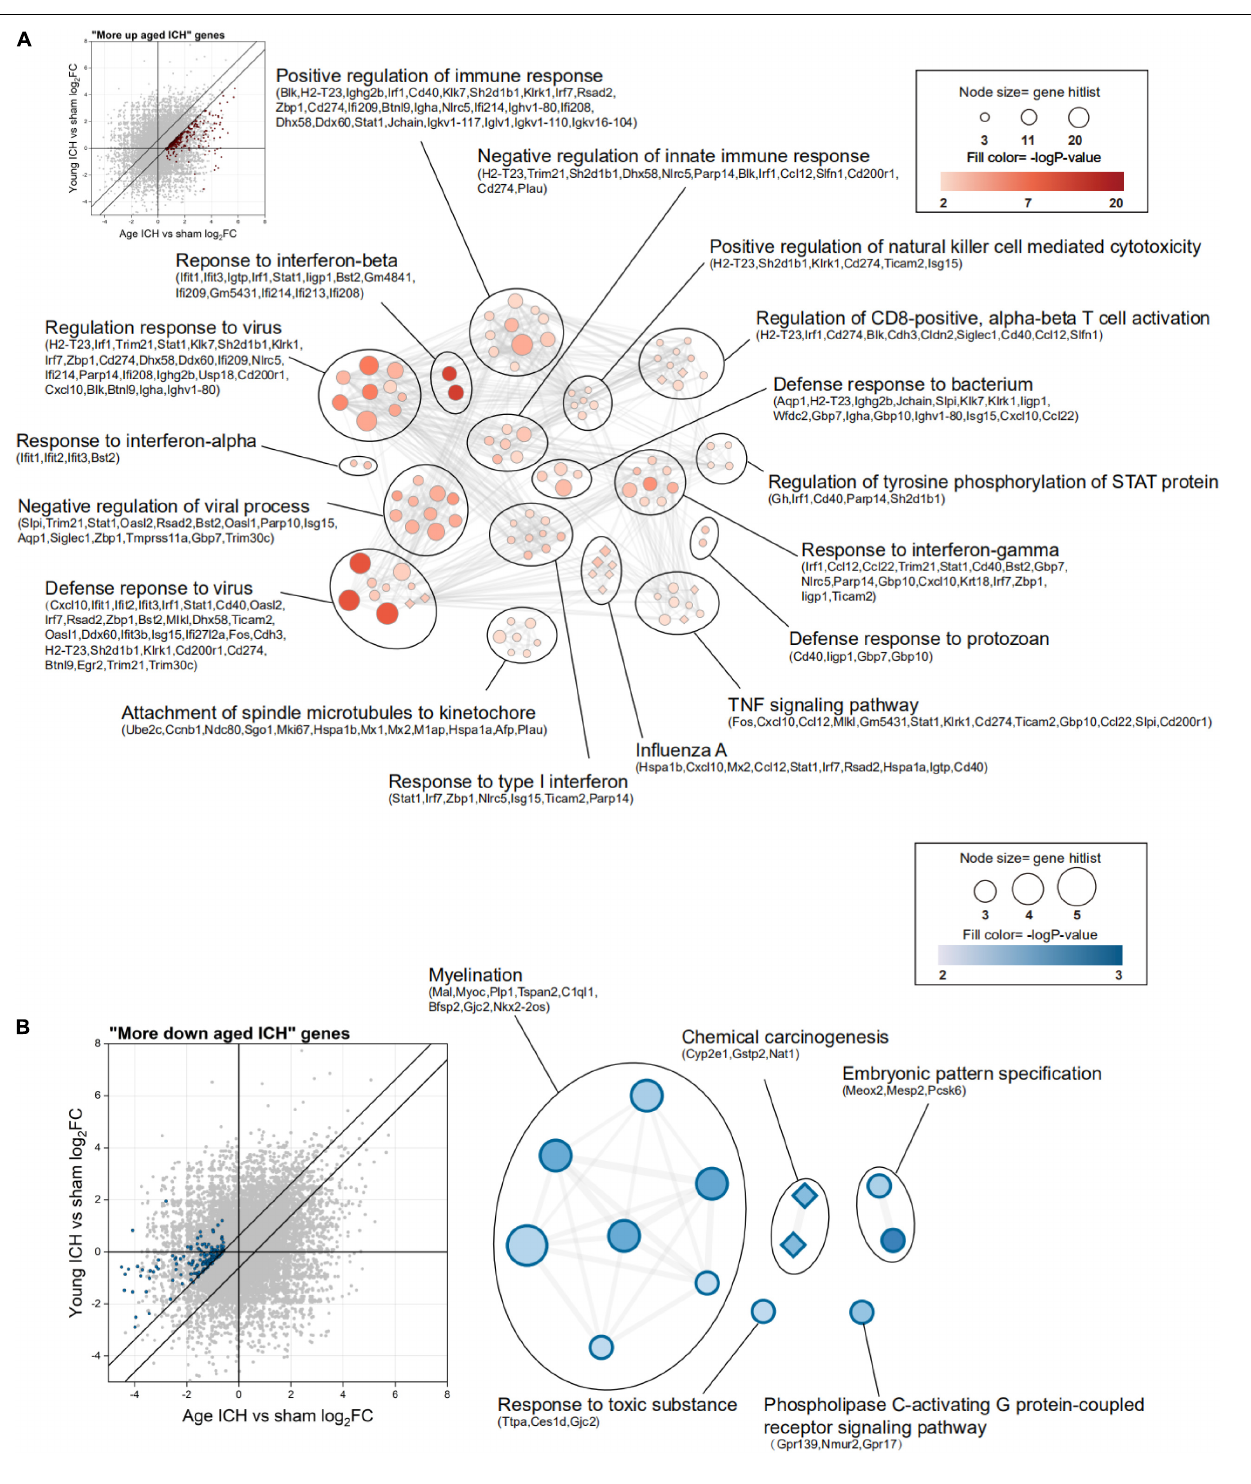
FIGURE 6 | Functional annotation of differentially expressed genes (DEGs) between young and aged mice after intracerebral hemorrhage (ICH). (A) The scatterplot shows DEGs that were more strongly upregulated after ICH in aged mice (“more upregulated in the aged ICH group”), and the enrichment map shows significantly enriched Gene Ontology (GO) terms (circles) and Kyoto Encyclopedia of Genes and Genomes (KEGG) pathways (diamonds) for these genes ( P < 0.01, z-score > 2). (B) The scatterplot and enrichment map for DEGs but for DEGs that were more strongly downregulated after ICH in aged mice (“more downregulated in the aged ICH group”). n = 3 per